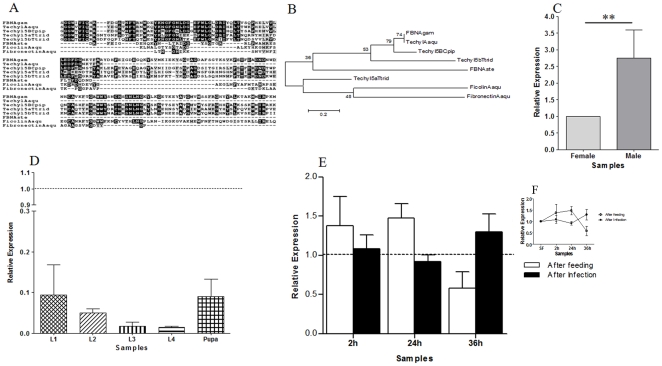
Characterization of techylectin related protein induction in mosquitoes fed on sugar, blood, or infected blood.A: Multiple aminoacid sequence alignment of mosquito fibrinogen related proteins. B: Phylogenetic tree for fibrinogen constructed based on the neighbor-joining method. C–F: Expression levels of techylectin related protein in A. aquasalis following different feeding regimens. C: sugar-fed males and females, D: immature stages, E and F: sugar-fed females (dotted line), and females after feeding and after P. vivax infection . h–hours, L1–first instar larva, L2–second instar larva, L3–third instar larva and L4–fourth instar larva. Accession numbers of fibrinogen sequences from: A. aquasalis (Aaqu) (Techyl - GR486377, Fibronectin - GR486898 and Ficolin - GR487133); A. gambiae (Agam) (FBN-AGAP004917-PA); A. stephensi (Aste) (FBN–CB602443), C. pipiens (Cpip) (Techyl5B - CPIJ000938); and Tachypleus tridentatus (Ttrid) (Techyl5a - AB024737 and Techyl5b - AB024738). +−: s.e.m.; * p<0.05, ** 0.03>p>0.01, *** p<0.01.